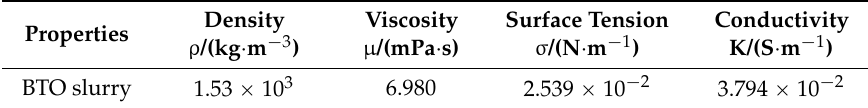
Table 1. Properties of the BTO slurry.